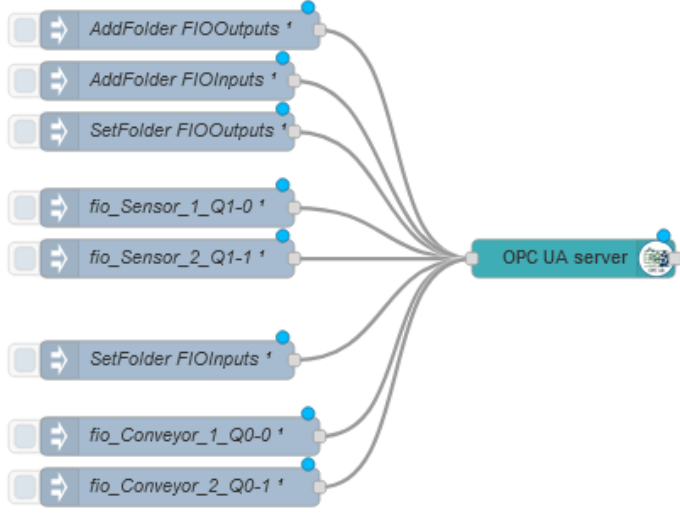
Figure 26. OPC UA server.